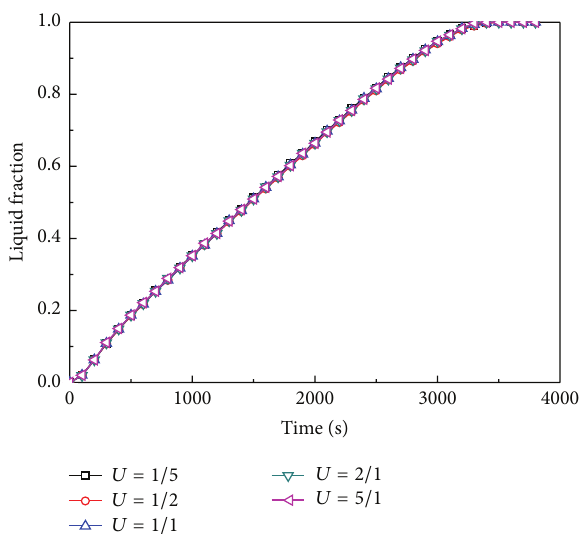
Figure 11: The liquid fraction as a function of time for the plates of different tooth rates.